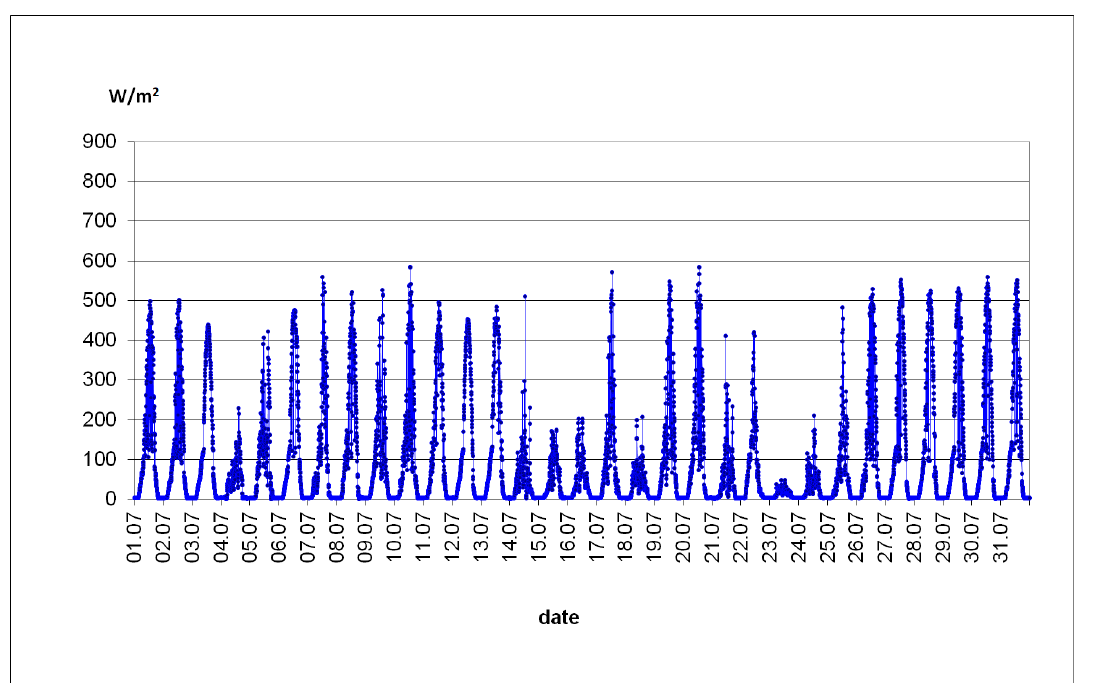
Figure 12. Graph of global solar irradiance incident on the southern vertical plane in July. The graphs (Figure 13–Figure 14) show the values of the heat flux density flowing through the storage layer and measured on the inner surface of the wall. A positive value in the heat flux density flow charts means that the wall gives off heat to the room, while a negative value means that the heat from the room is absorbed by the wall and transferred to the outside.